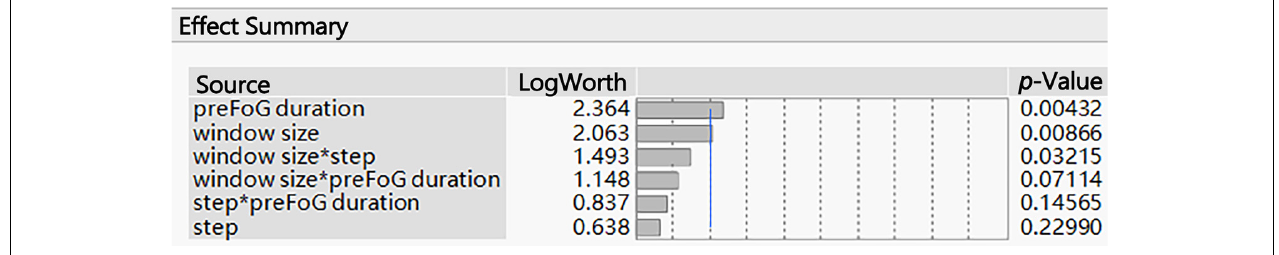
Frontiers in Human Neuroscience |